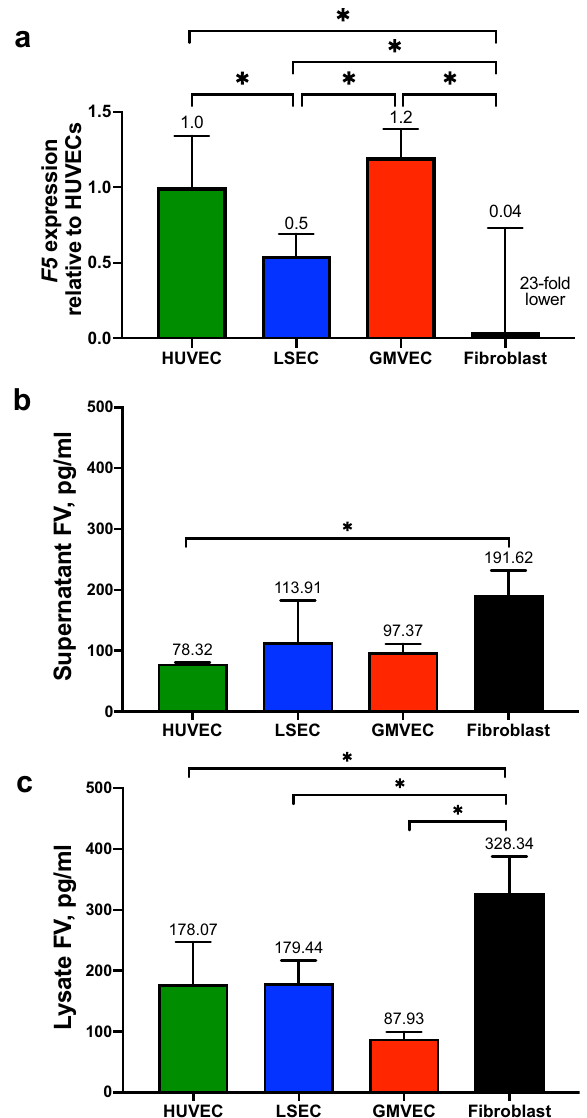
Figure 1. Gene expression levels of F5 and FV protein levels in the supernatant and lysate/cell membrane fractions of ECs and fibroblasts. ( a ) The expression levels of F5 in each cell type was quantified relative to F5 levels in HUVECs after normalization to GAPDH in each real-time PCR analysis. Data shown are means + SD from four to six separate RNA extractions for each cell type (HUVEC, n = 5, LSEC, n = 4, GMVEC, n = 6, fibroblast, n = 4). Quantification of FV in cell ( b ) supernatant and ( c ) lysate/cell membranes by ELISA in HUVECs, LSECs, GMVECs, and fibroblasts (n = 3 for each cell type). FV protein concentrations (means + SD) in pg/ml were normalized to total lysate protein to account for cell number differences. * p <